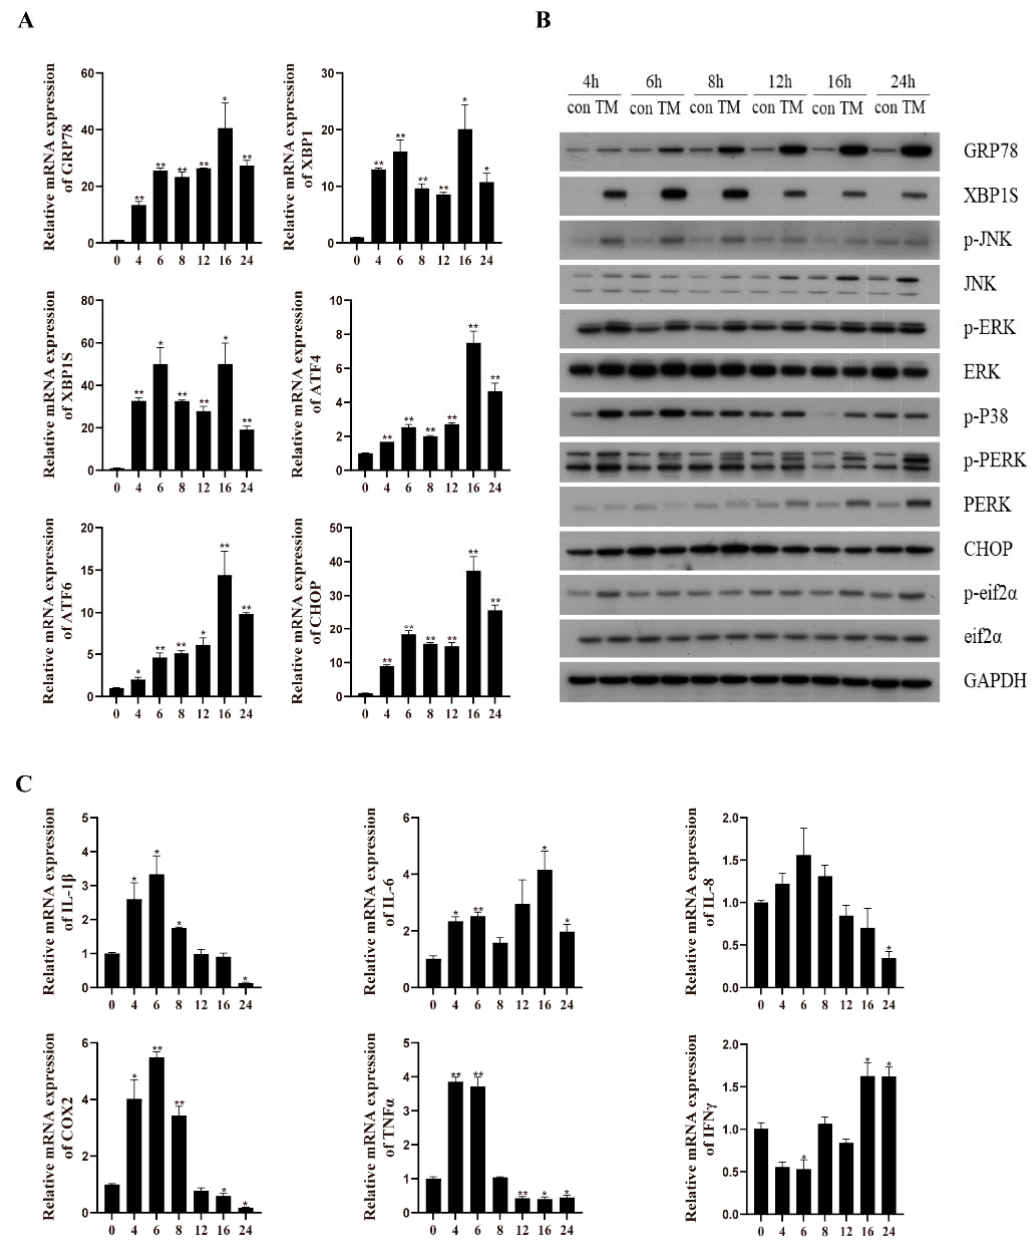
Figure 1. Effects of 1 µ M TM treatment on ER stress and inflammation in macrophages of large yellow croakers. ( A ) Relative mRNA expression of ER stress-related genes after TM treatment for different time points. ( B ) Protein levels of ER stress-related proteins and inflammatory-related proteins after TM treatment for different time points. ( C ) Relative mRNA expression of inflammatory genes after TM treatment for different time points. Values are presented as mean ± SEM ( n = 3). * Significant difference ( p < 0.05); ** highly significant difference ( p < 0.01).